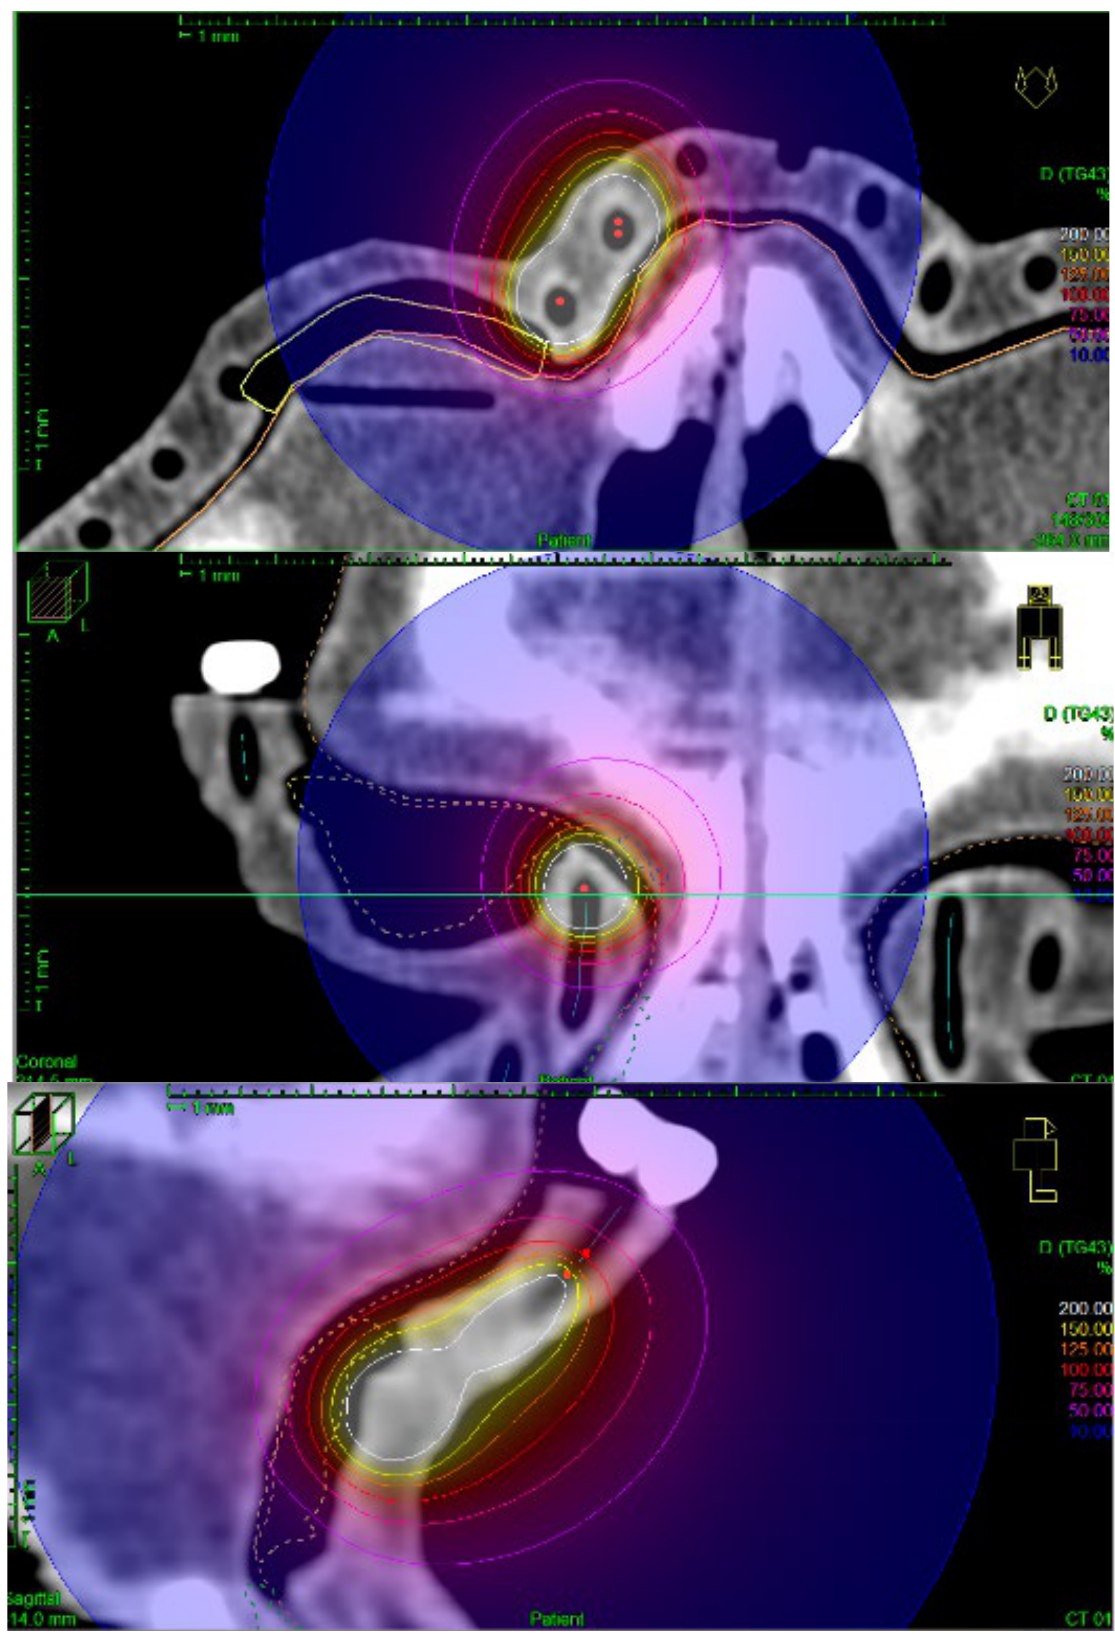
Figure 8. Detailed view of sample isodoses obtained during the treatment planning process; the optimization of the treatment plans.